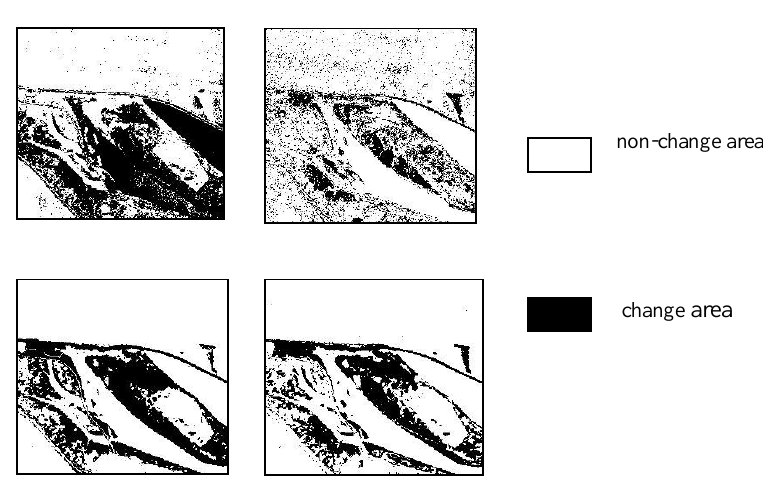
Fig. 4 The change detection results of the experimental